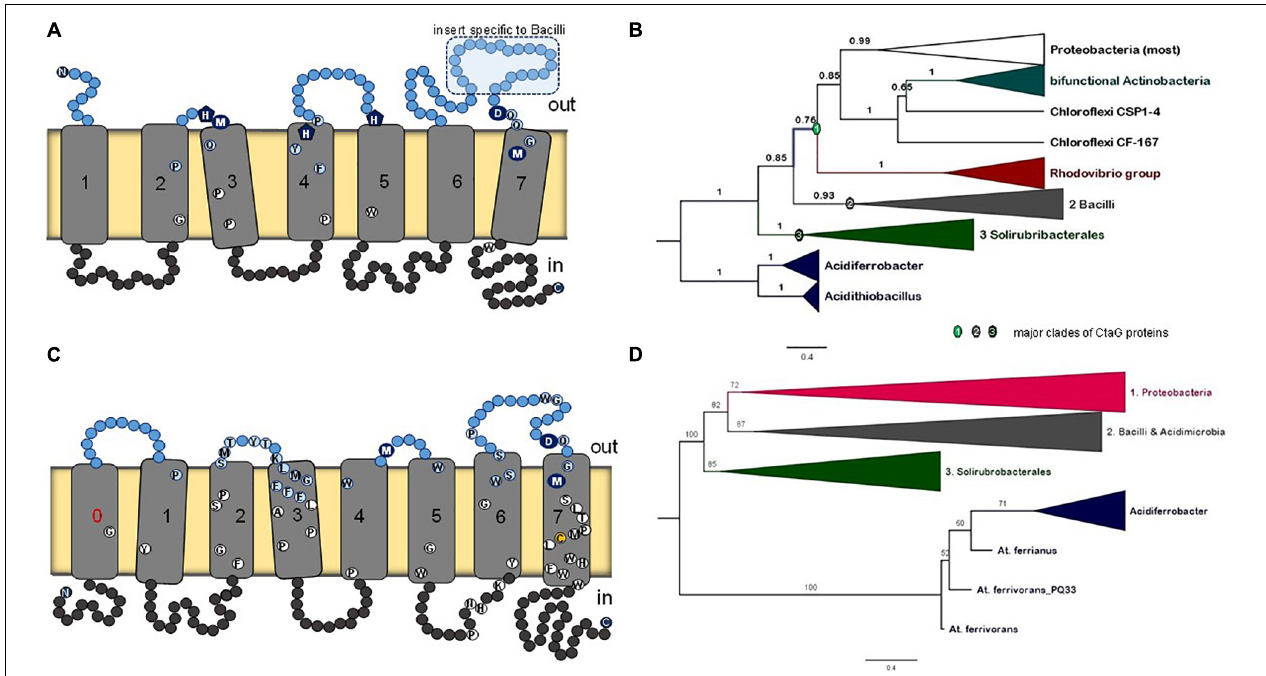
FIGURE 8 | Membrane structure and phylogeny of caa3_CtaG proteins. (A) Schematic model for the deduced transmembrane structure of B. subtilis caa3_CtaG, which was rendered with the same design as that used for CtaA ( Figure 2 ). Residues potentially acting as Cu ion ligands are indicated with blue circles or pentagons including the invariant D249 (see text). Other highly conserved residues in caa3_CtaG proteins are depicted as in Figure 2 . (B) Representative Bayesian tree obtained with the BEAST package using 40 caa3_CtaG sequences that were selected to represent the major clades previously found in wide phylogenetic analysis after removing proteins exhibiting long branches ( Supplementary Figures 13, 14a ). A similar tree was obtained with ML inference using the IQ-Tree program ( Supplementary Figure 14b ). The alignment contained a total of 242 amino acid sites. Posterior support of branches is expressed in decimals. (C) Schematic model for the structure of caa3_ctaG of acidophilic iron-oxidizing Proteobacteria, exemplified by that of Acidithiobacillus ferrianus (Norris et al., 2020). (D) The ML tree was obtained with the IQ-Tree program using an alignment of 42 caa3-CtaG sequences including their N terminal part [i.e., not trimmed as in Panel (B) ]. The alignment contained a total of 337 amino acid residues and is made available upon